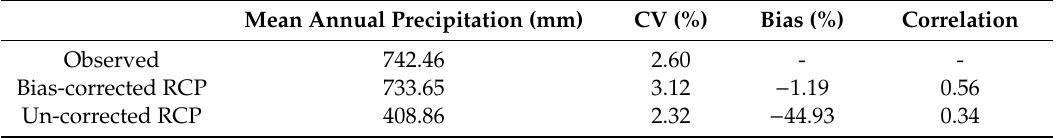
Table 3. Performance evaluation of observed and downscaled historical representative concentration